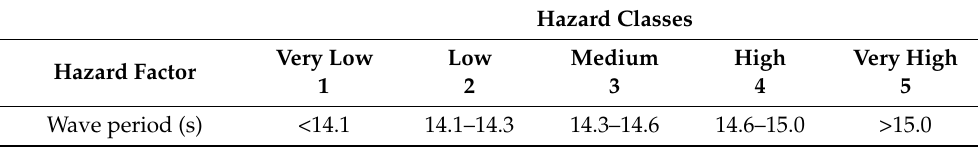
Table 10. Hazard classification concerning the wave period hazard